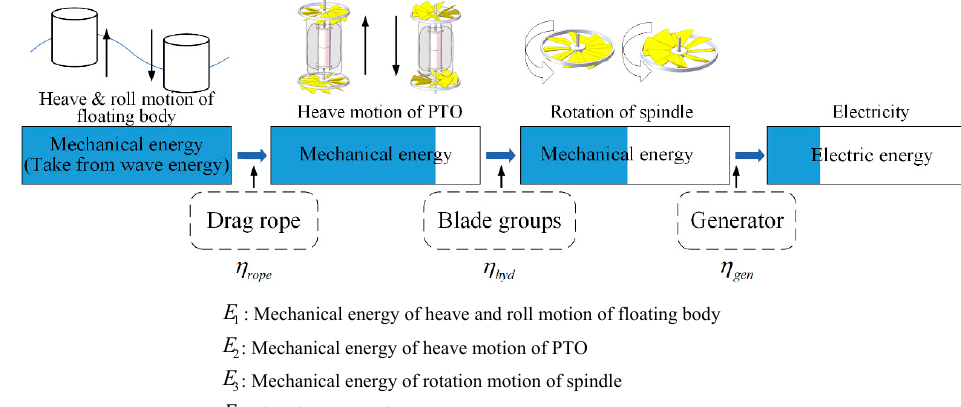
Figure 5. Energy ‐ conversion processes of point ‐ absorption WEC. Figure 5. Energy-conversion processes of point-absorption